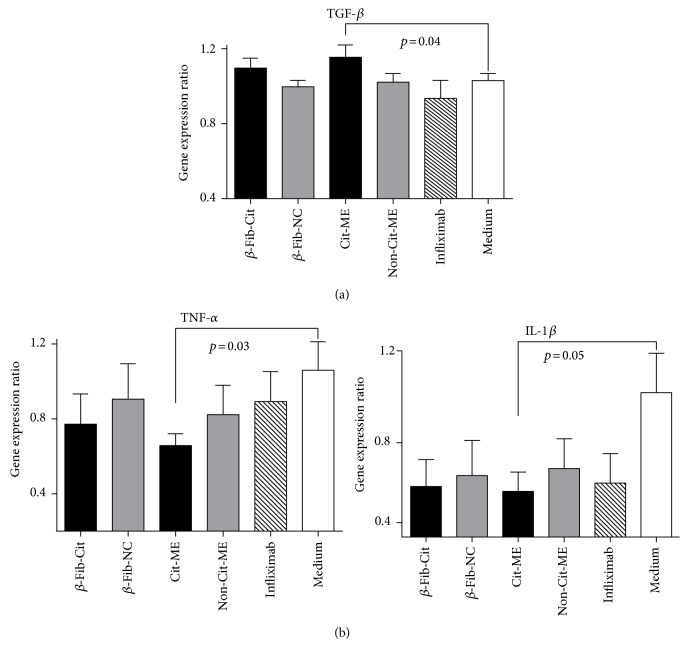
Cit-ME peptide upregulates TGF-β and downregulates TNF-α and IL-1β mRNA expression. PBMC of RA patients (n = 12) were cultured (5 × 105 cells/well) for 24 hours in the presence of citrullinated peptides (1.25 μg/mL). TGF-β, TNF-α, and IL-1β mRNA gene expression was determined by real-time RT-PCR. Results are presented as the mean ± SE percentage of gene expression.